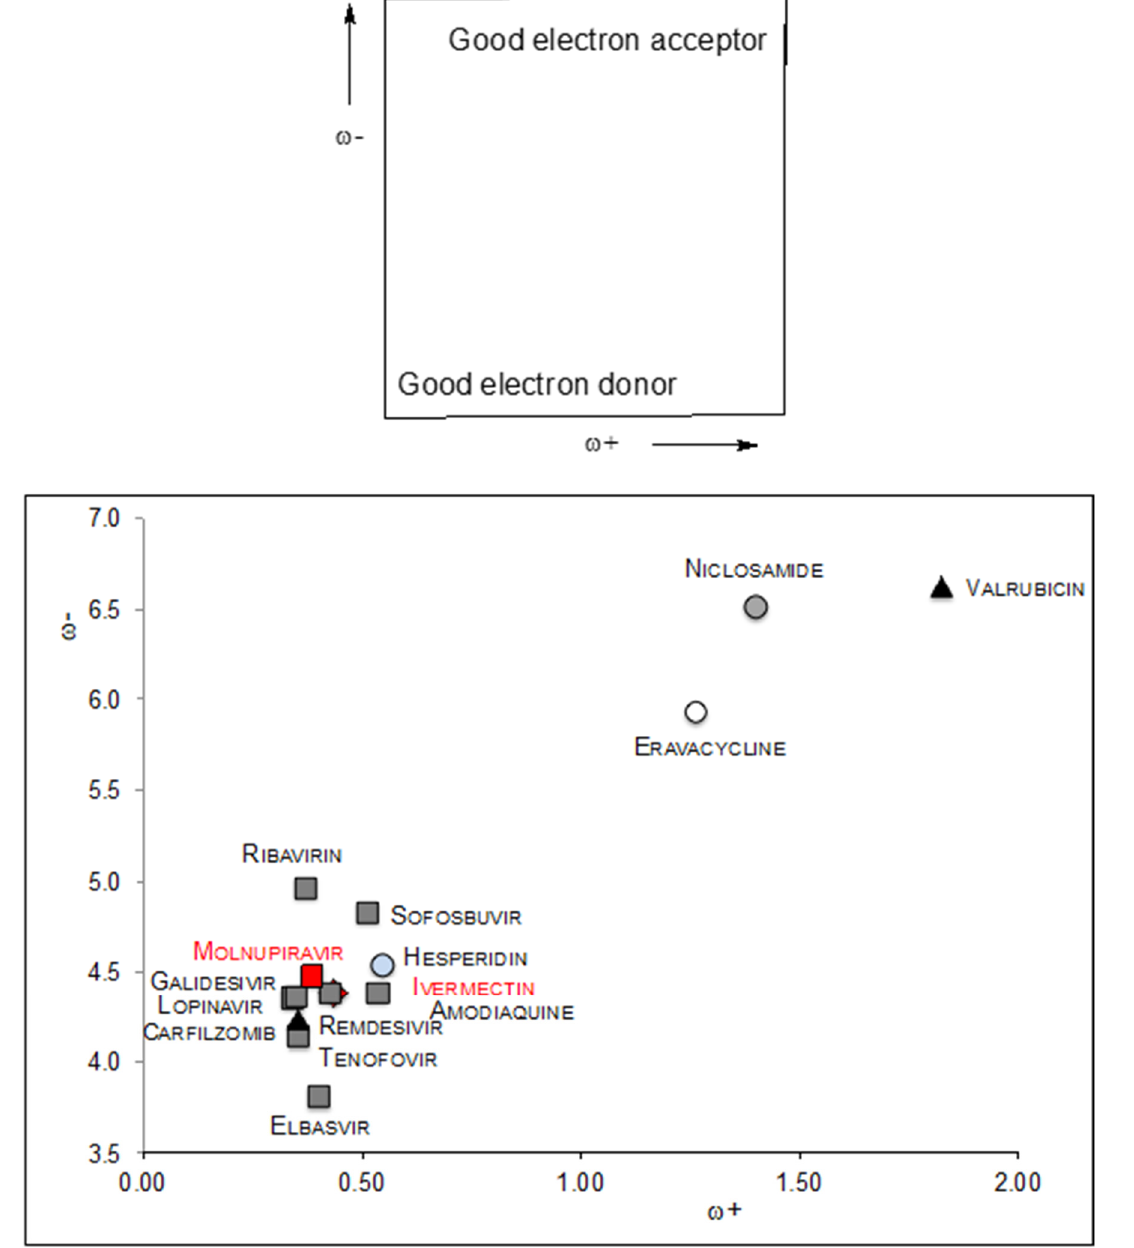
Figure 2. Donor-Acceptor MAP (DAM) of the studied molecules. Amodiaquine is an antiviral drug with one Cl atom and is a good electron donor. Hesperidin has been reported as an antioxidant, concurring with the results presented in Figure 2, because it is located within the electron donor zone. Elbasvir is also a good electron donor, but its main action mechanism refers to its ability to inhibit the 5A protein. Ribavirin and Galidesivir are effective as potent drugs against COVID-19, as they bind tightly to its RdRp (a crucial viral enzyme in the life cycle of RNA viruses). They can also act as free radical scavengers because they donate electron. There are another three molecules (Remdesivir, Sofosbuvir and Tenofovir) that are good electron donors, but the reported action mechanism against COVID-19 is that they interact with RdRp. Carfilzomib is an antineoplastic agent and a selective proteasome inhibitor. It works by stopping or slowing the growth of cancer cells in the body and is also a good electron donor, but